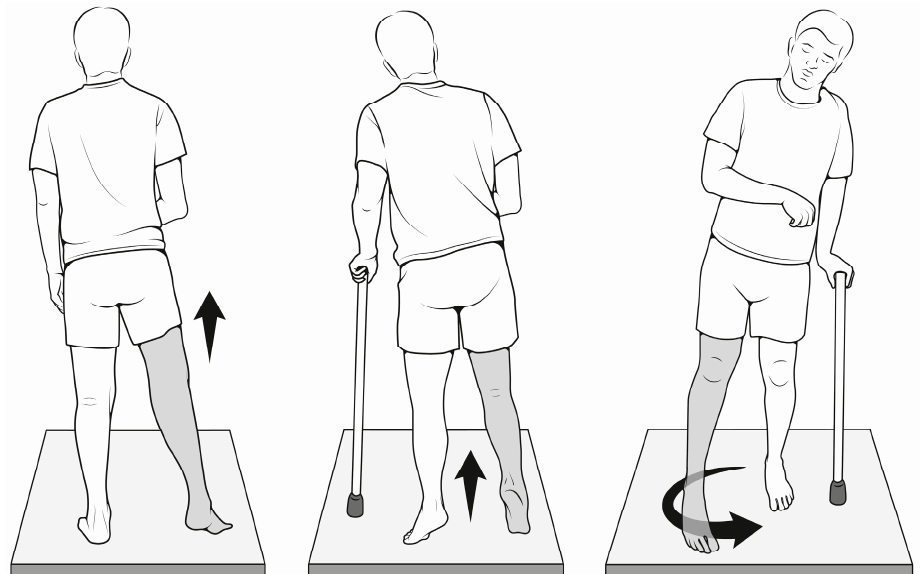
Figure 1. Compensatory gait patterns allowing paretic limb clearance during swing. From left: hip hiking, vaulting and circumduction.